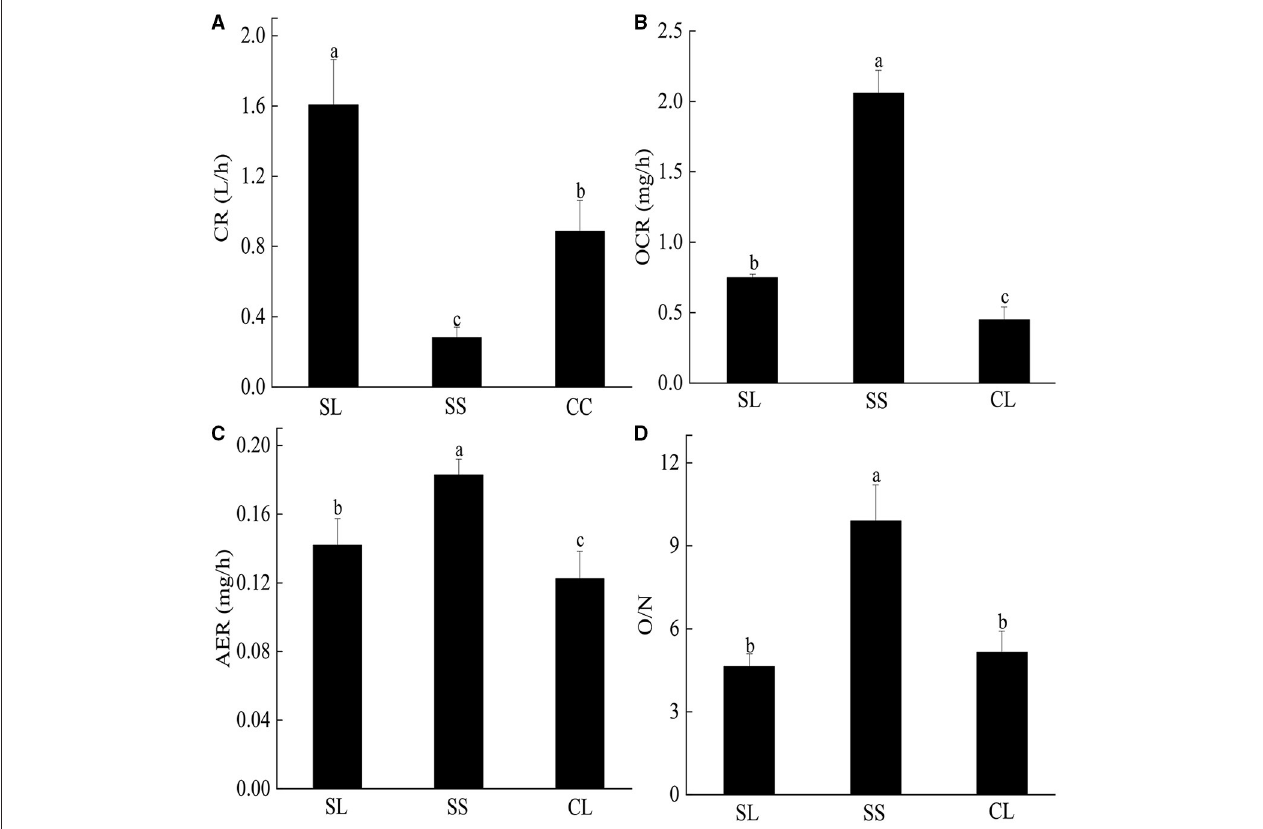
FIGURE 3 | (A–D) The clearance rate, oxygen consumption rate, ammonia excretion rate, and O/N rate of P. f. martensii in SL, CL, and SS groups. Means ± S.D. are presented. n = 3 replicate per treatment. Different letters represent significant differences ( p < 0.05).